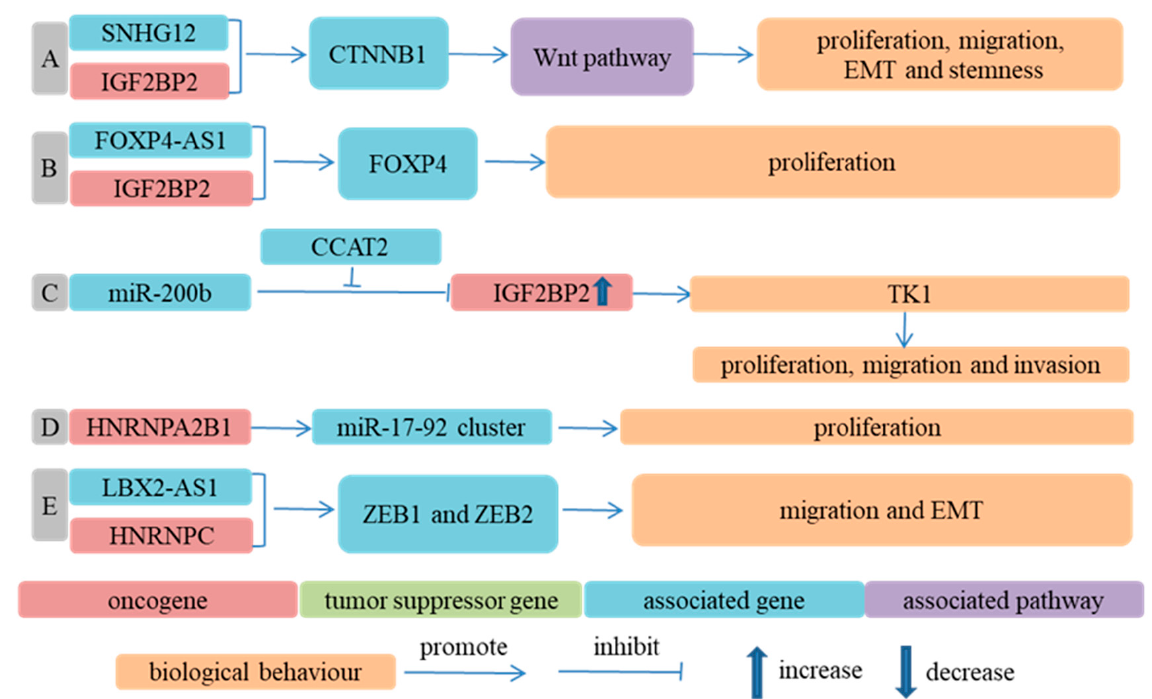
Figure 3. m 6 A RNA binding proteins participate in ESCA progression in an m 6 A-dependent way. ( A ) Ref. [64] IGF2BP2 interacted with SNHG12 to enhance mRNA stability of CTNNB1, elevated expression of β -catenin encoded by CTNNB1, activated Wnt signaling pathway and thus